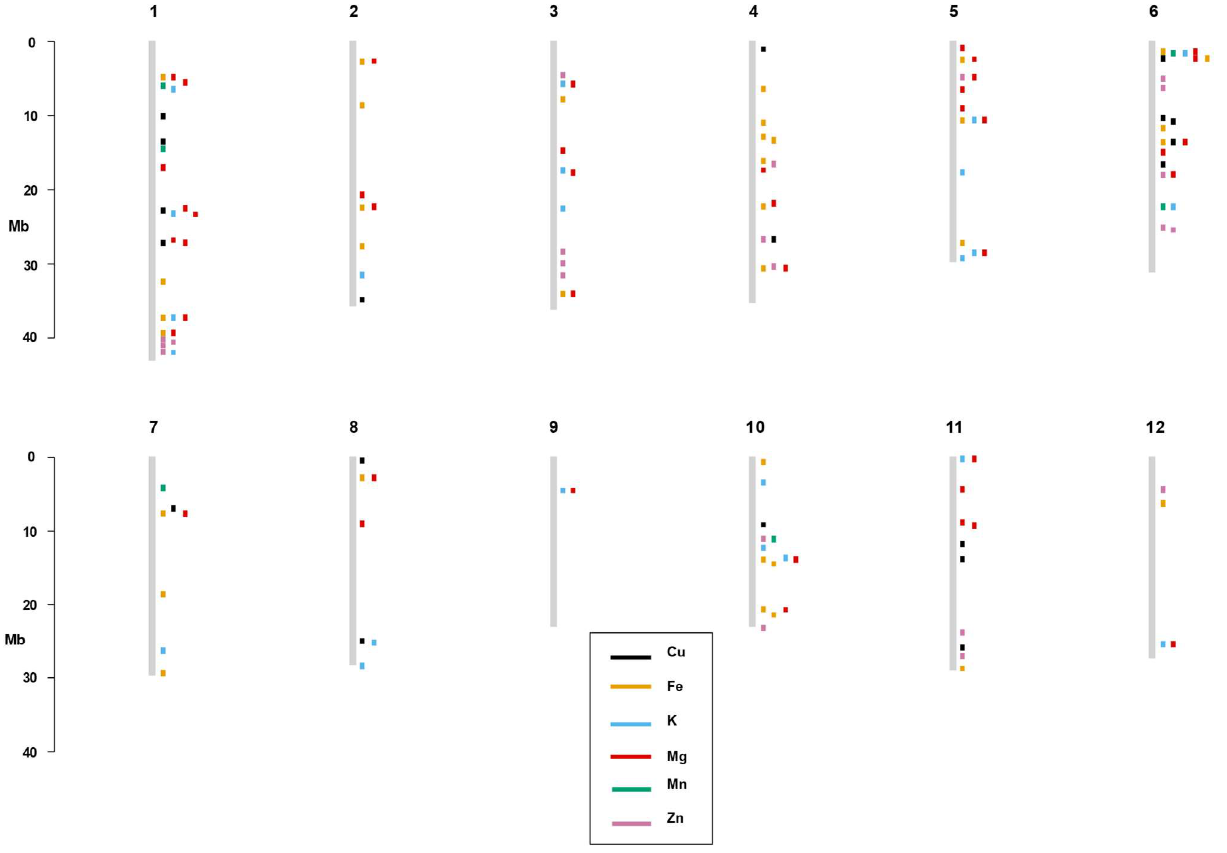
Figure 5. Physical map of the significant SNP markers before applying 15% FDR multi-test correction found in the study for the six mineral elements. SNP positions are depicted by the rectangular box with specific color showing the corresponding mineral elements. Rice chromosomes are displayed by vertical lines.